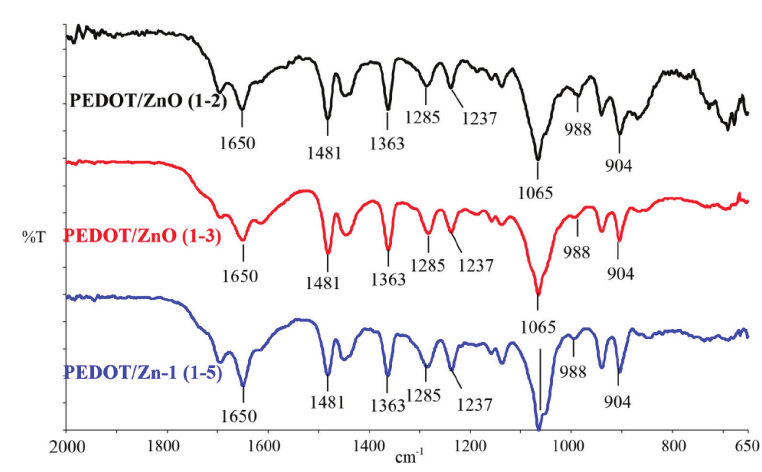
Fig. 2 – FTIR spectrograms of PEDOT/ZnO samples synthesized by various monomer to APS oxidant ratio (1:2, 1:3,